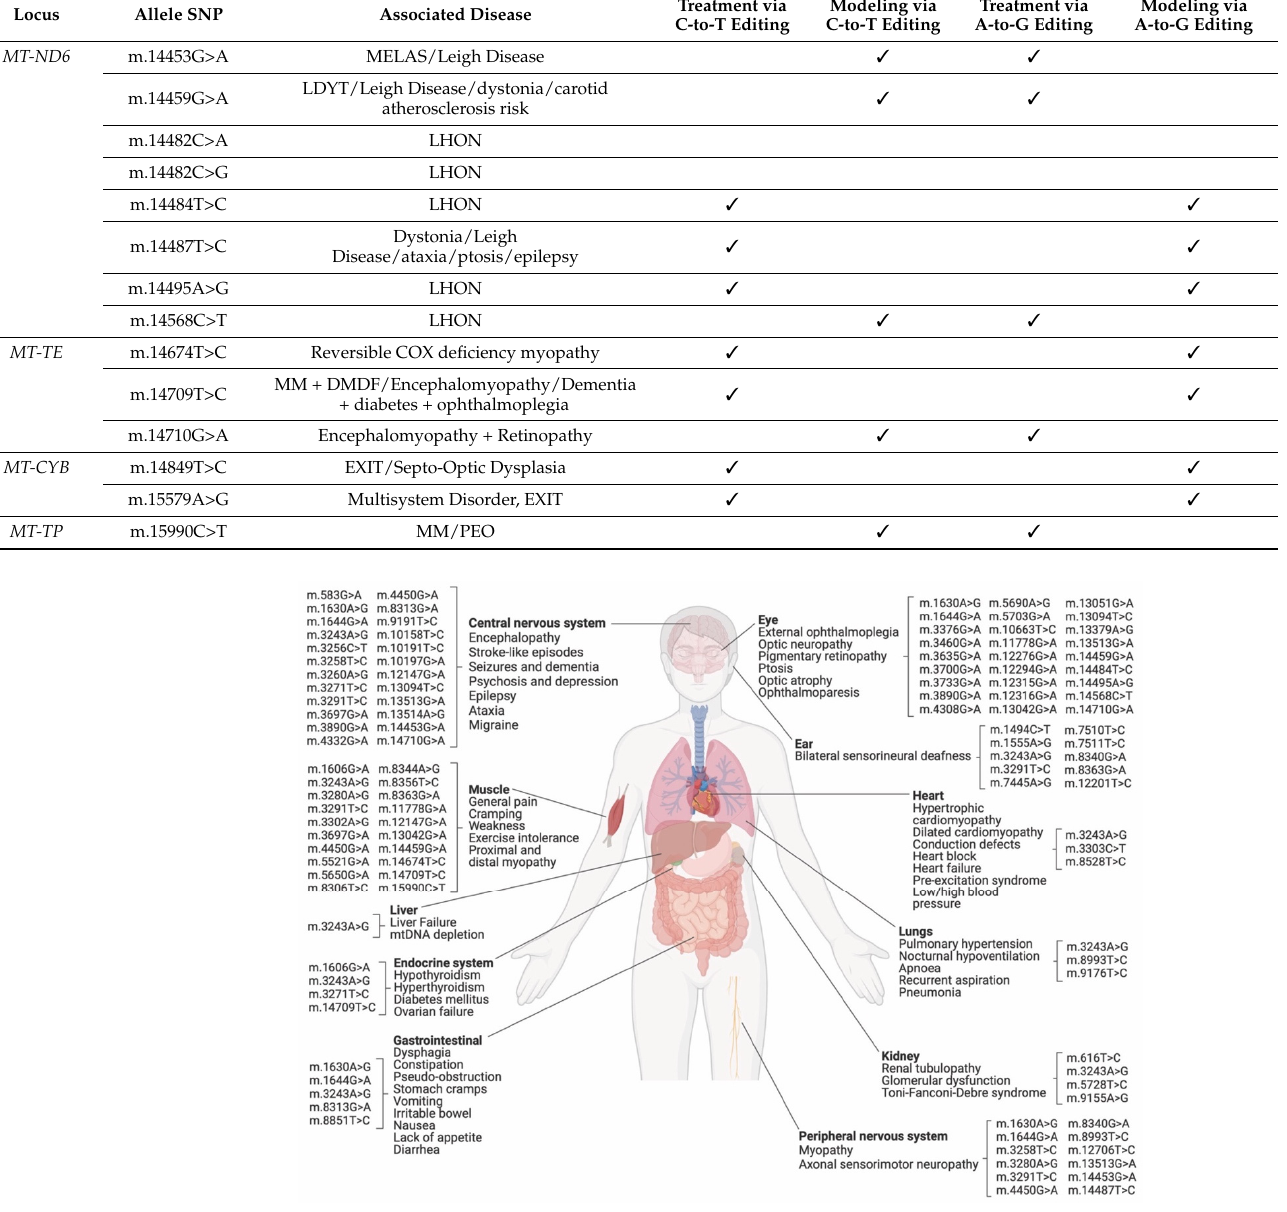
Figure 2. The potential use of present mitochondrial base editing technologies to correct or model disease-associated mtDNA point mutations. This figure displays common clinical features of mito- chondrial disorders and their associated point mutations, as collated in Table 1 and derived from MITOMAP [13]. These mitochondrial diseases could potentially be corrected or modeled by C•G- to-T•A or A•T-to-G•C editing utilizing DbCBEs or TALEDs, respectively (Table 1). DdCBEs with evolved DddA6 show improved C•G-to-T•A editing at TC motifs, while DdCBEs with evolved DddA11 offer significant C•G-to-T•A editing at CC and AC along with TC motifs. Additionally, the recently-established DdCBE_Ss platform is highly effective at catalyzing C•G-to-T•A editing at GC motifs [14]. Moreover, the TALED platform enables A•T-to-G•C mtDNA editing in a con- text-independent manner, potentially increasing bystander editing at target loci. The existing base editing technologies hold promise for correcting or modeling pathogenic variants in mtDNA, with some limitations that need to be considered, as outlined above. (This figure was created with Bio- Render.com, accessed on 15 January 2023.) Table 1. Pathogenic mitochondrial mutations confirmed with MITOMAP [13]. Out of 91 confirmed pathogenic point mutations, 86 can potentially be corrected or modeled using the DdCBE and TALED mtDNA base editing platforms. Figure 2 contains further details.